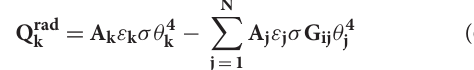
apparatus and, therefore, by the tendency of the system to behave as a blackbody